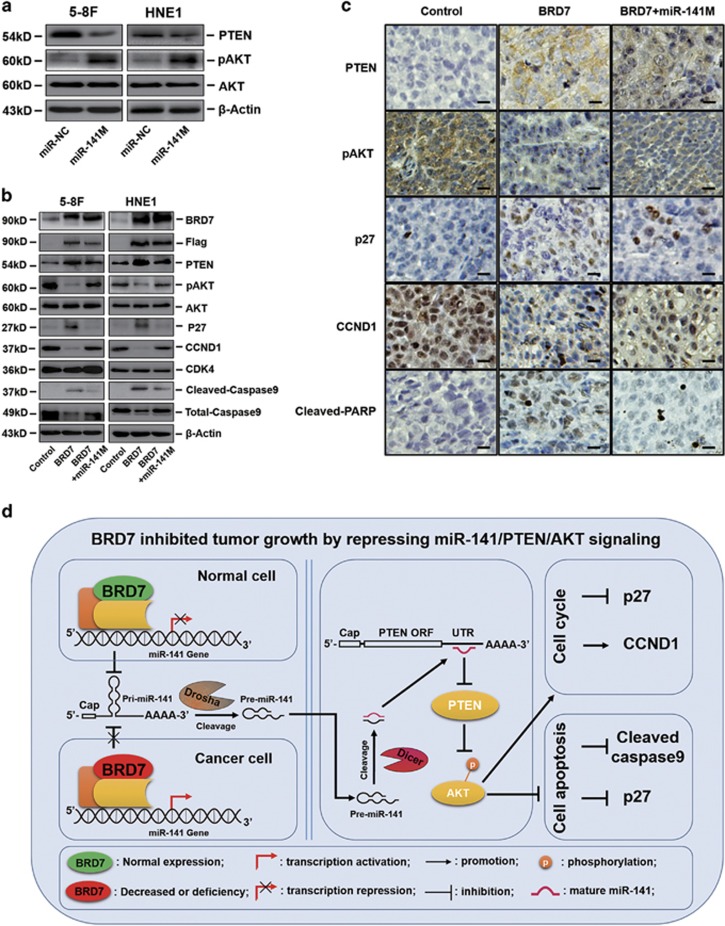
BRD7 inhibited tumor growth by repressing miR-141/PTEN/AKT signaling. (a) PTEN and phosphorylated AKT protein expression levels in miR-141 mimic-transfected 5-8F and HNE1 cells were analyzed by western blotting, and (b) significantly differently expressed proteins downstream of PTEN/AKT signaling were involved in cell-cycle progression (p27, CCND1 and CDK4) and survival (cleaved-caspase-9, total-caspase-9 and p27) when miR-141 expression was restored in BRD7-overexpressing 5-8F and HNE1 stable cell lines, respectively. β-Actin served as an internal control. (c) IHC (DAB staining) for PTEN, p-AKT, p27, CCND1 and cleaved-PARP in the 5-8F xenograft model. Three tumors were analyzed per group using immunohistochemistry for the molecules mentioned above. Original magnification, × 200; the size bars represent 25 μm. Control: Vector+miR-NC, BRD7: BRD7+miR-NC. (d) A schematic map showing the tumor suppressive mechanism of BRD7 that occurs by repressing the miR-141/PTEN/AKT pathway in NPC